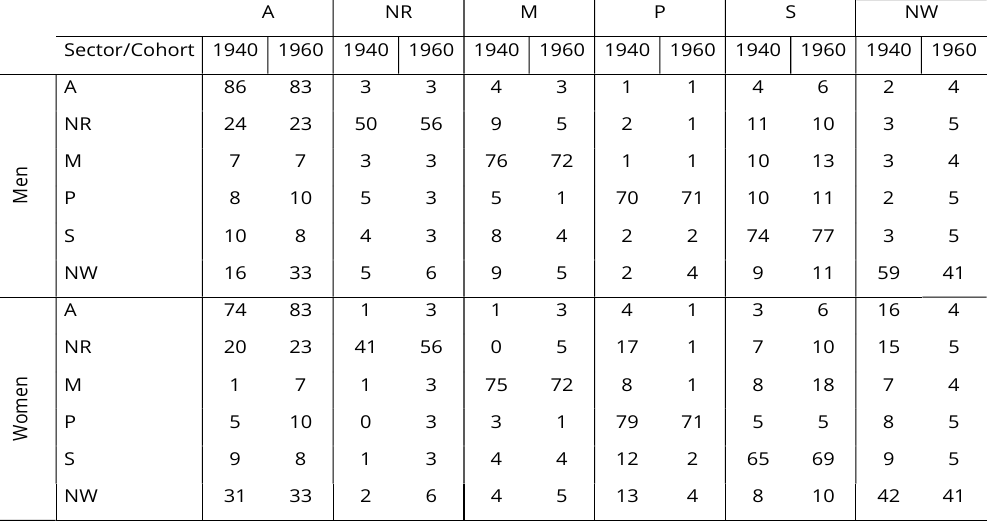
Table 1. Average transition rates between sectors by cohort and sex in percentage (A = agriculture, NR = natural resources, M = manufacturing, S = services, P = public, NW = not